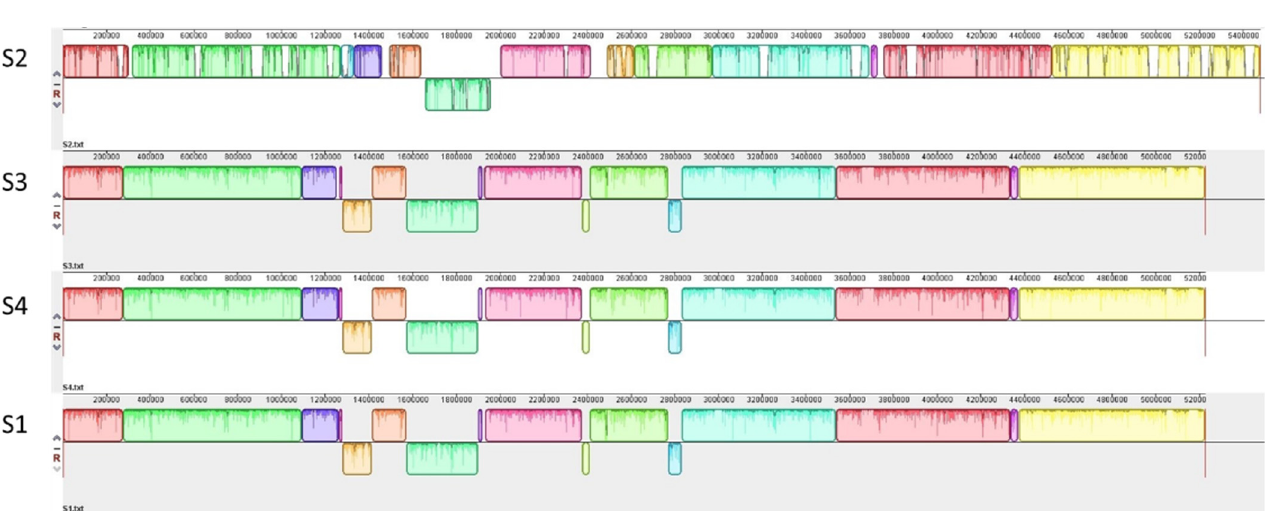
Figure 1. Multiple genome alignment was performed using the Mauve software. Each sequence is represented by a horizontal panel of blocks. The colored blocks indicate homologous sequence regions between the genomes. Blocks below the center line in each genome are inverted sequences with respect to the other genomes.